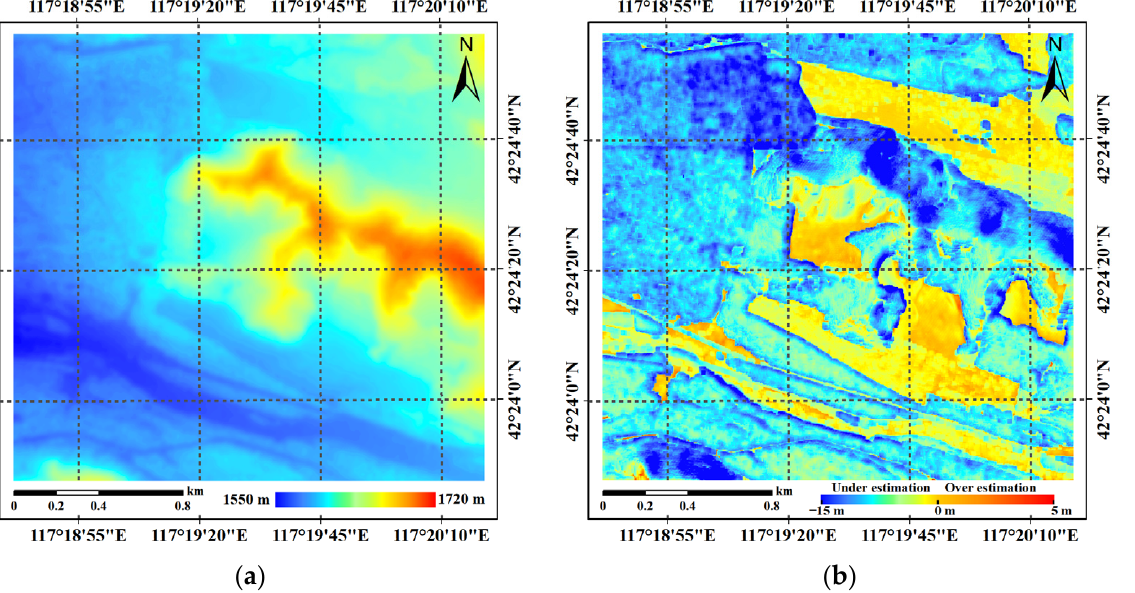
Figure 10. The initial result of DSM extraction and deviation between DSM X-InSAR and DSM LiDAR : ( a ) DSM X-InSAR ; ( b ) Difference between DSM X-InSAR and DSM LiDAR .